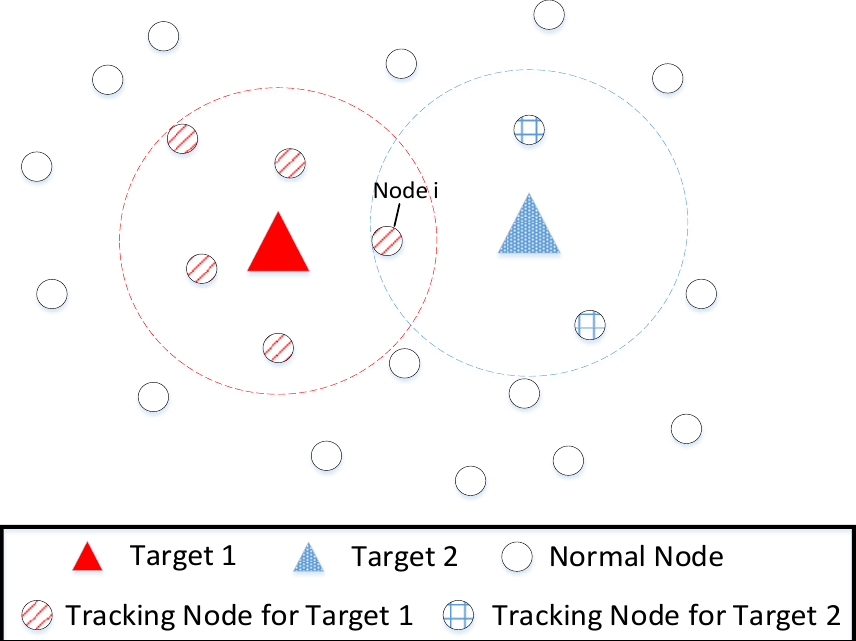
Figure 1. Traditional nearest-neighbor-scheduling